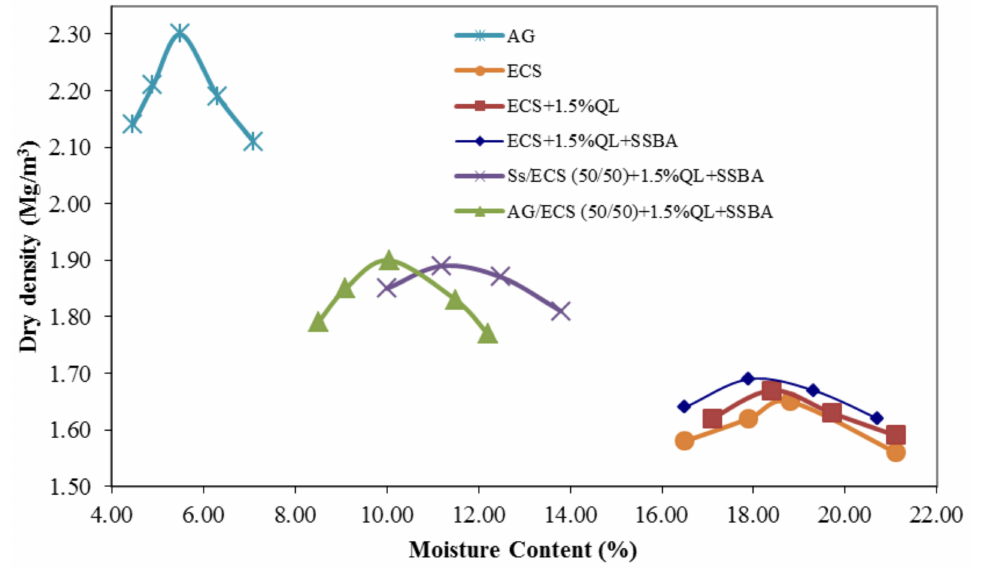
Figure 6. Moisture–density